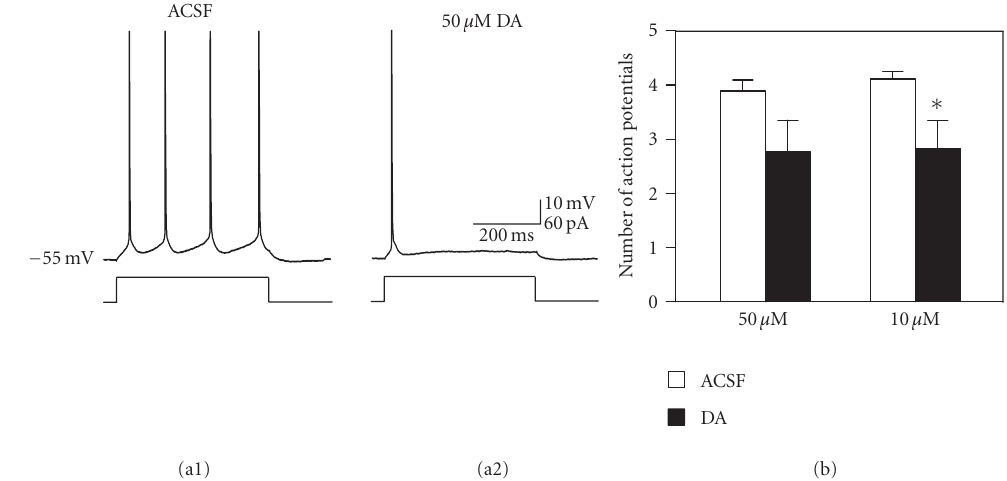
Figure 7: The number of action potentials elicited by positive current steps is reduced by dopamine. (a) Traces show action potentials generated in response to 500 milliseconds duration, 60 pA current steps before and after application of 50 μ M dopamine. The example shown reflects a particularly large reduction to only one action potential following application of dopamine. Action potentials are truncated. (b) Group data show a reduction in firing for both the 10 and 50 μ M conditions but only the reduction in the 10 μ M condition was